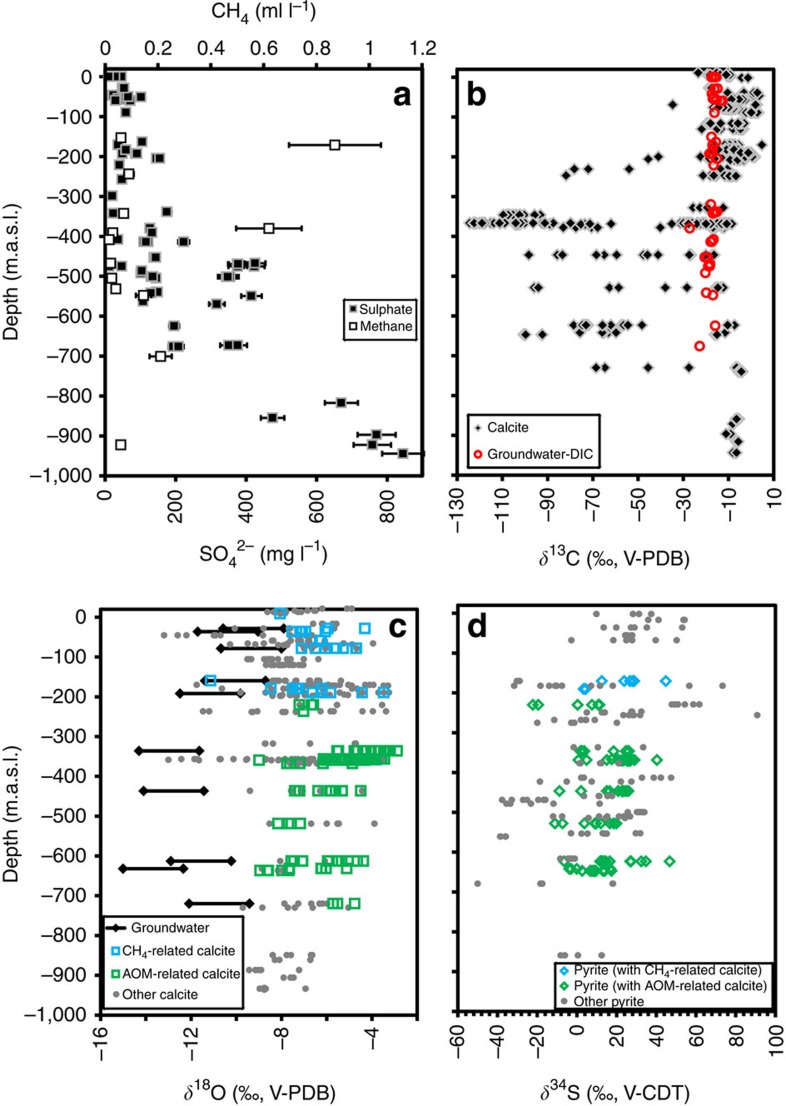
Depth-related variations of geochemical variables in the groundwater and in calcite.(a) Sulphate and methane concentrations34 in the groundwater. (b) δ13Ccalcite and groundwater δ13CDIC. (c) δ18Ocalcite. Panel c includes a range for hypothetical calcite precipitated from the current groundwater at the same depth where the AOM- or methanogenesis-calcite coatings were collected. Equation 1,000 lnα(Calcite−H20)=18.03(103 T−1)−32.42 (ref. 36) is used to calculate the fractionation factor (α) between oxygen in water and calcite at borehole water temperatures of 5–20 °C (hence the range). (d) δ34S values of pyrite in paragenesis with AOM-related crystals, together with pyrite in paragenesis with methanogenesis-related calcite and pyrite without any indicated methane relation31. For the stable isotope analyses, the symbol sizes are larger than the analytical uncertainties. Groundwater data are listed in Supplementary Table 2 and full stable carbon, oxygen and sulphur isotope data for calcite and pyrite in Supplementary Tables 1 and 3.